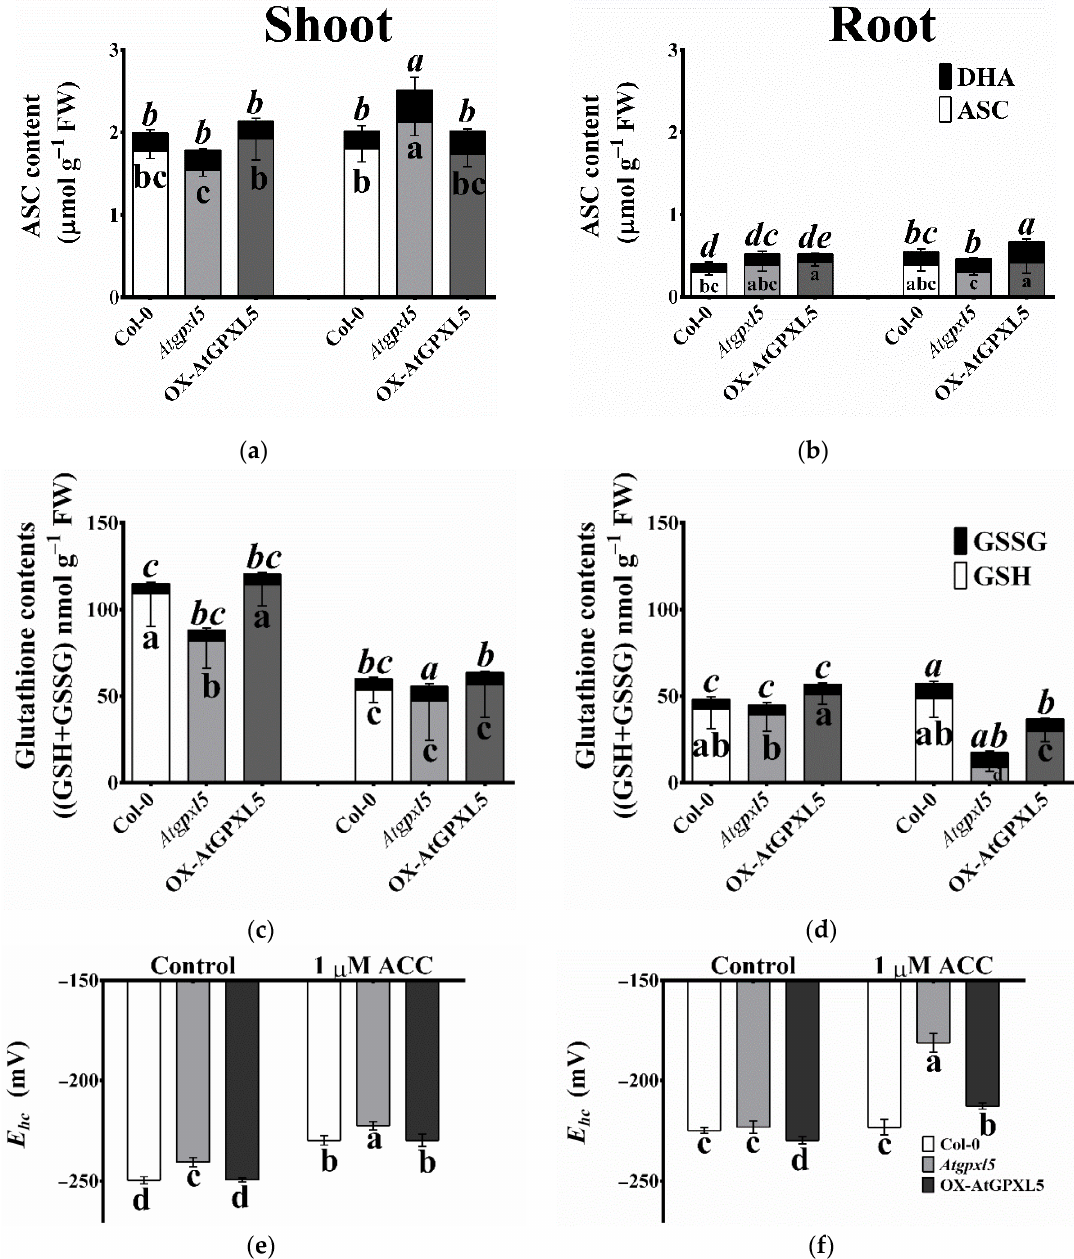
Figure 8. Effect of one-day 1 µ M ACC on the ascorbate ( a , b ) and glutathione ( c , d ) contents, and the calculated glutathione half-cell redox potential ( E hc ; e , f ) in shoots ( a , c , e ) and roots ( b , d , f ), respectively, of 6-week-old Arabidopsis thaliana wild type (Col-0), Atgpxl5-1 mutant ( Atgpxl5 ) and OX-AtGPXL5 plants. In the case of ASC and GSH contents, the dark segment of the bars represents the oxidised dehydroascorbate (DHA) and oxidised glutathione (GSSG), respectively. The data are presented by mean values ± SD, n = 3. Data were analysed using one-way ANOVA followed by Duncan’s test. Different letters represent data considered statistically significant at p ≤ 0.05. Normal lettering is used at the reduced and italics at the oxidised forms of